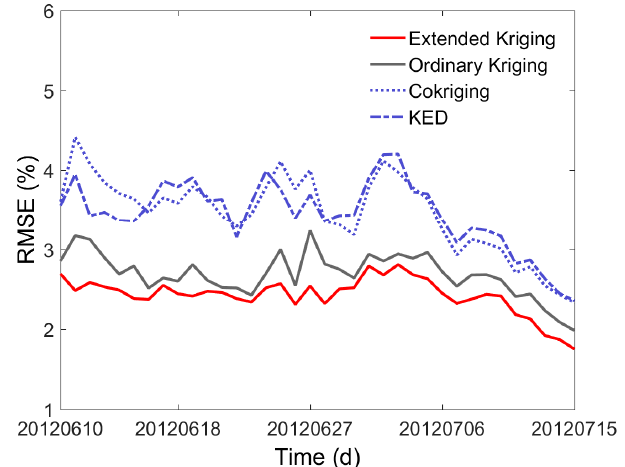
Figure 11. Comparison of the RMSE calculated by the Extended Kriging, OK, Co-kriging, and KED.